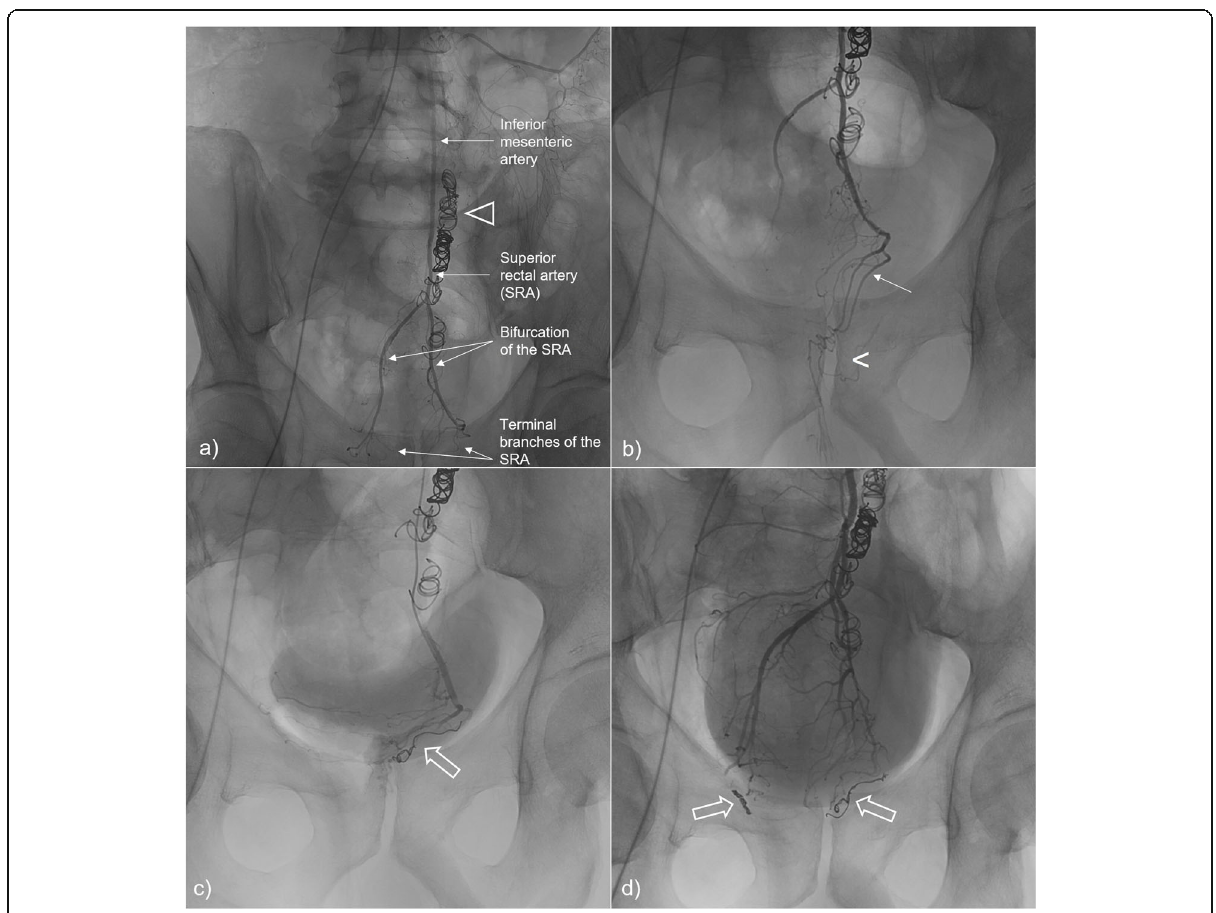
Fig. 1 Endovascular coil-embolization of the superior rectal artery (SRA). Angiography of the inferior mesenteric artery A ) displays normal anatomy, with opacification of the SRA and its terminal branches; also note the presence of coils in the inferior mesenteric vein ( Δ ) from a previous venous embolization. Distal catheterization and opacification of the left branch of the SRA on B ) allows better anatomic detail of the left terminal branches (arrow), selectively embolized with microcoils (open arrow) on C ). Final control angiography after embolization of the left and right terminal branches of the SRA D ) shows bilateral microcoils (open arrows) with upstream contrast stasis and absence of blood flow in